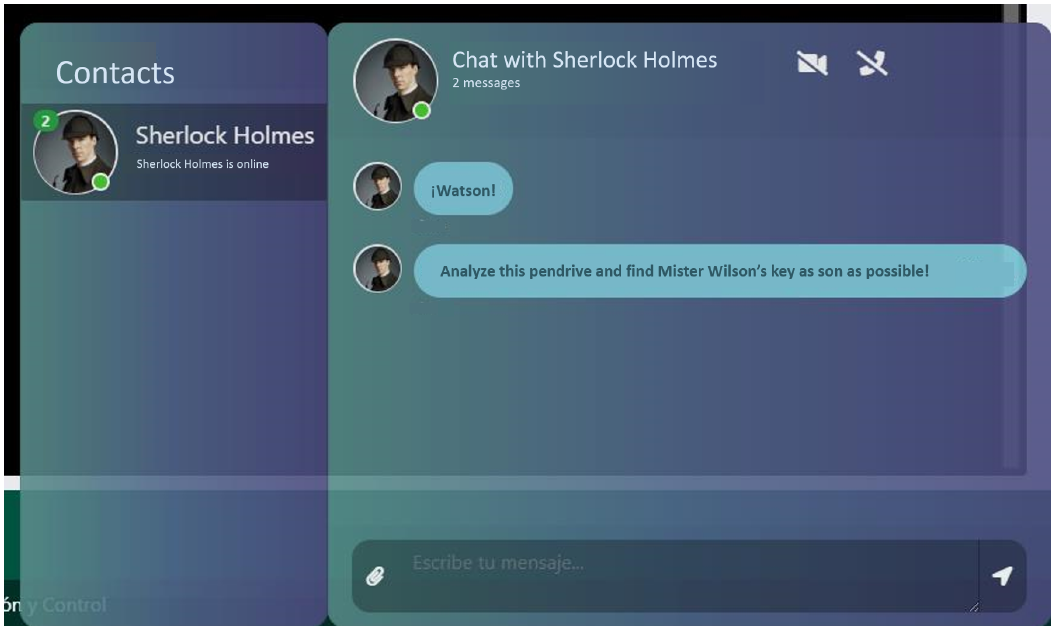
Figure 4. Chat-bot for the cloud game-based educative platform